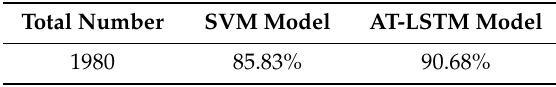
Figure 14. Confusion matrix for model identification 0.6 s in advance. ( a ) AT-LSTM model. ( b ) SVM model.